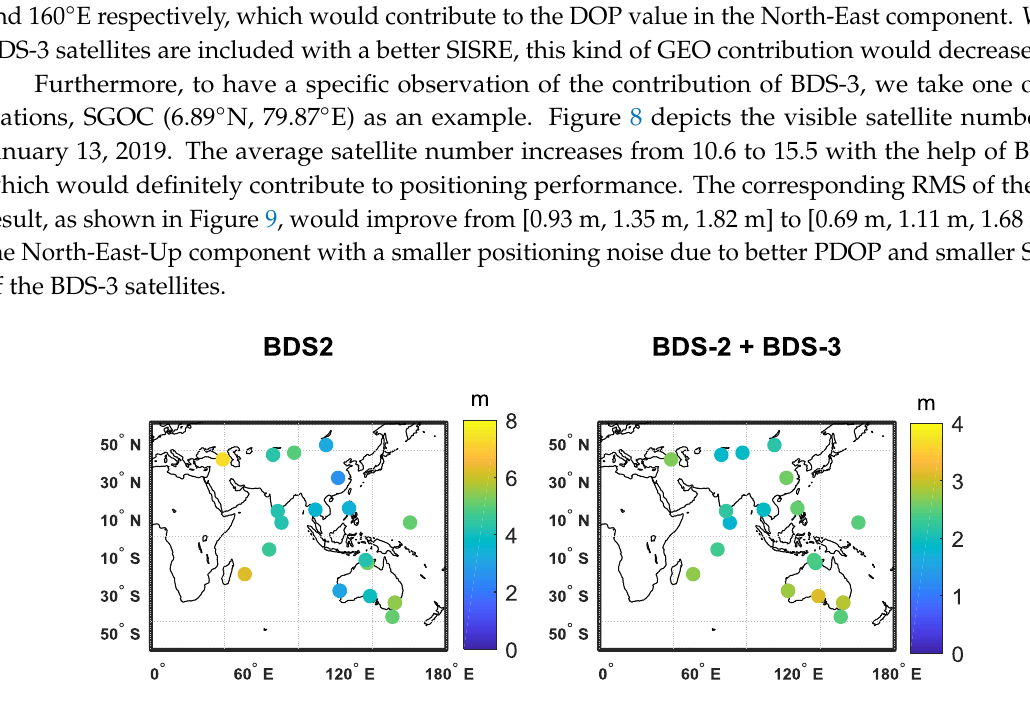
Figure 7. RMS of SPP performance for BDS-2-only (left) and BDS-2+BDS-3 (right) around the Asia-Pacific and Indian Ocean region (20 stations, one week). Please note the different scale of the legend. Table 4. BDS-2-only and BDS-2+BDS-3 SPP performance around the Asia-Pacific and Indian Ocean region (in meter). The results are from one-week of data for 20 stations.